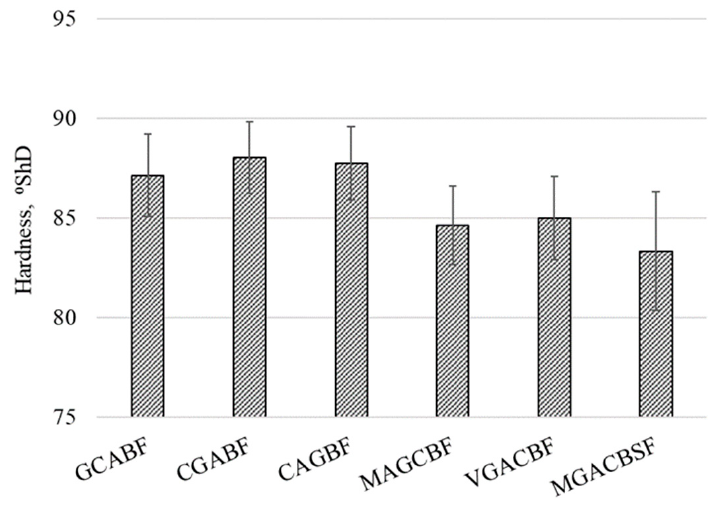
Figure 2. Hardness of EP ‐ laminates.